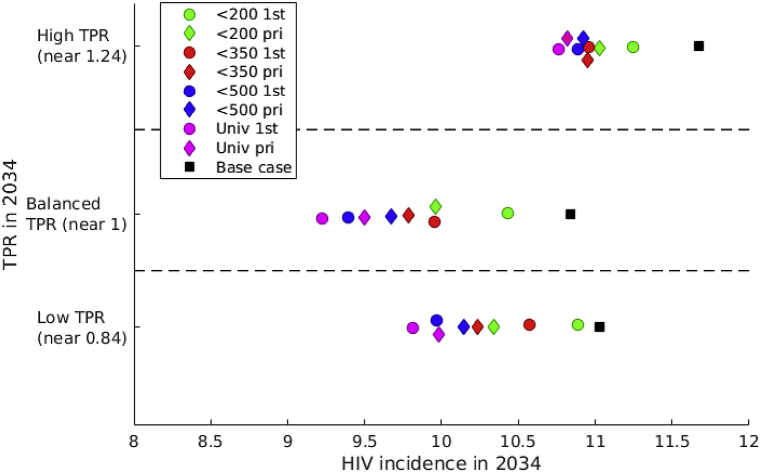
Effect of TPR-preserving strategies on HIV incidence. Expected HIV incidence in 2034. “First” strategies are noted “1st” and “priority” strategies are noted “pri”. HIV incidence in 2019 is 14 new infections per 1000 person-years for all these simulations.